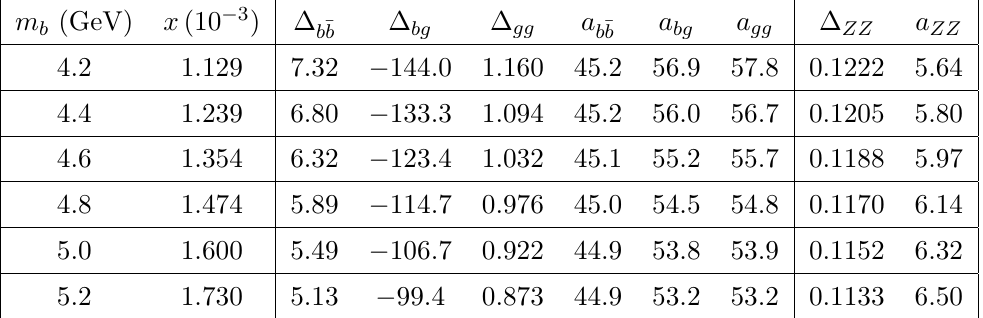
Table 1 . Numerical results of the LO form factors and their NLO corrections for representative values of the bottom-quark pole mass and with M H = 125